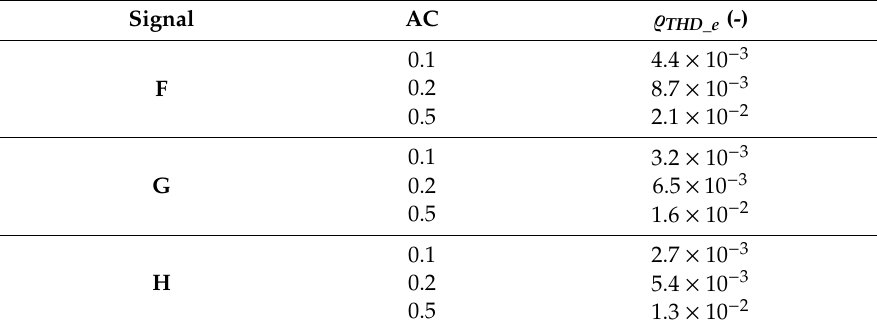
Table 4. Relative standard deviation of the estimated